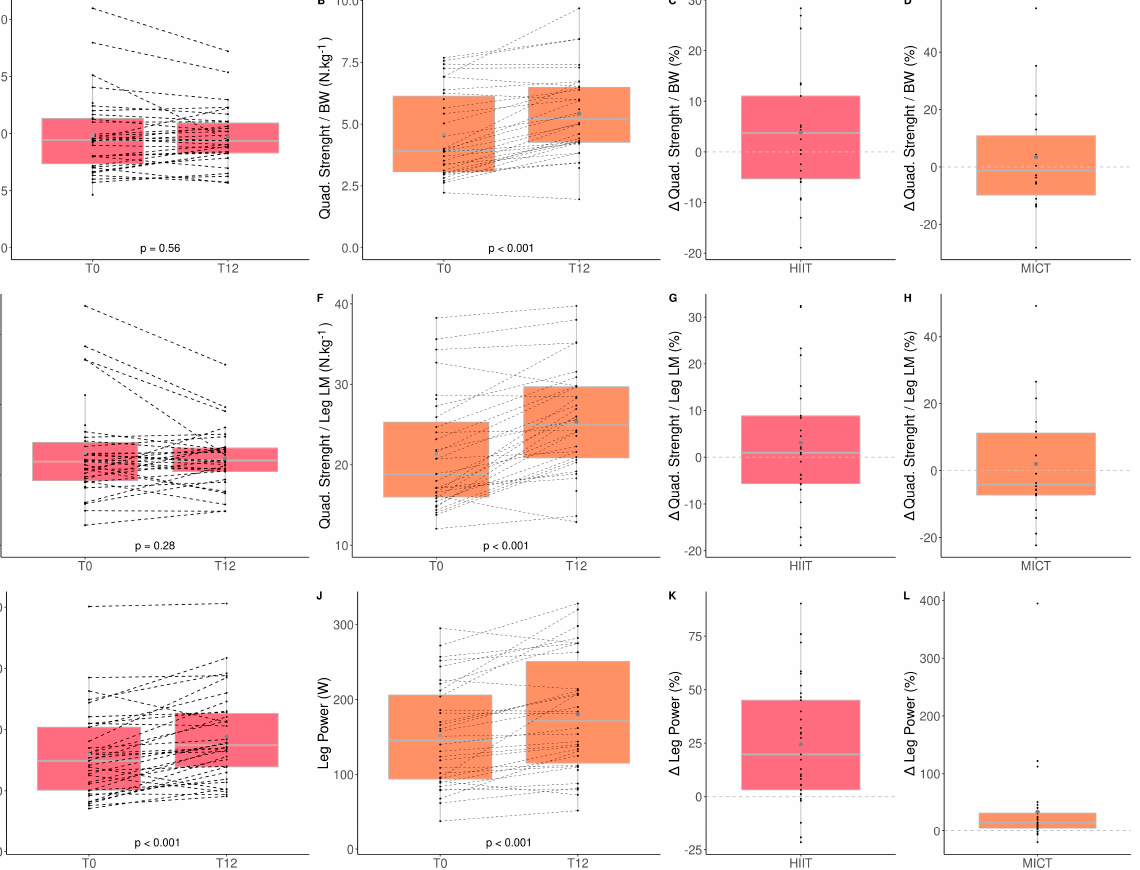
Figure 2. Impact of HIIT and MICT on skeletal muscle function. HIIT = high-intensity interval training (pink), MICT = moderate-intensity continuous training (orange), T0 = before the 12-week intervention, T12 = after the 12-week intervention, delta change between T0 and T12 is expressed in %. Quadriceps strength normalized to body weight for HIIT ( A ), Quadriceps strength normalized to body weight for MICT ( B ), delta change of quadriceps strength normalized to body weight for HIIT ( C ), delta change of quadriceps strength normalized to body weight for MICT ( D ), quadriceps strength normalized to leg lean mass for HIIT ( E ), quadriceps strength normalized to leg lean mass for MICT ( F ), delta change of quadriceps strength normalized to leg lean mass for HIIT ( G ), quadriceps strength normalized to leg lean mass for MICT ( H ), leg power for HIIT ( I ), leg power for MICT ( J ), delta change of leg power for HIIT ( K ), delta change of leg power for MICT ( L ). Each black dot represents a subject (the dashed line connects the T0 and T12 values of each subject), the grey point the mean, and the grey line in the boxplot the